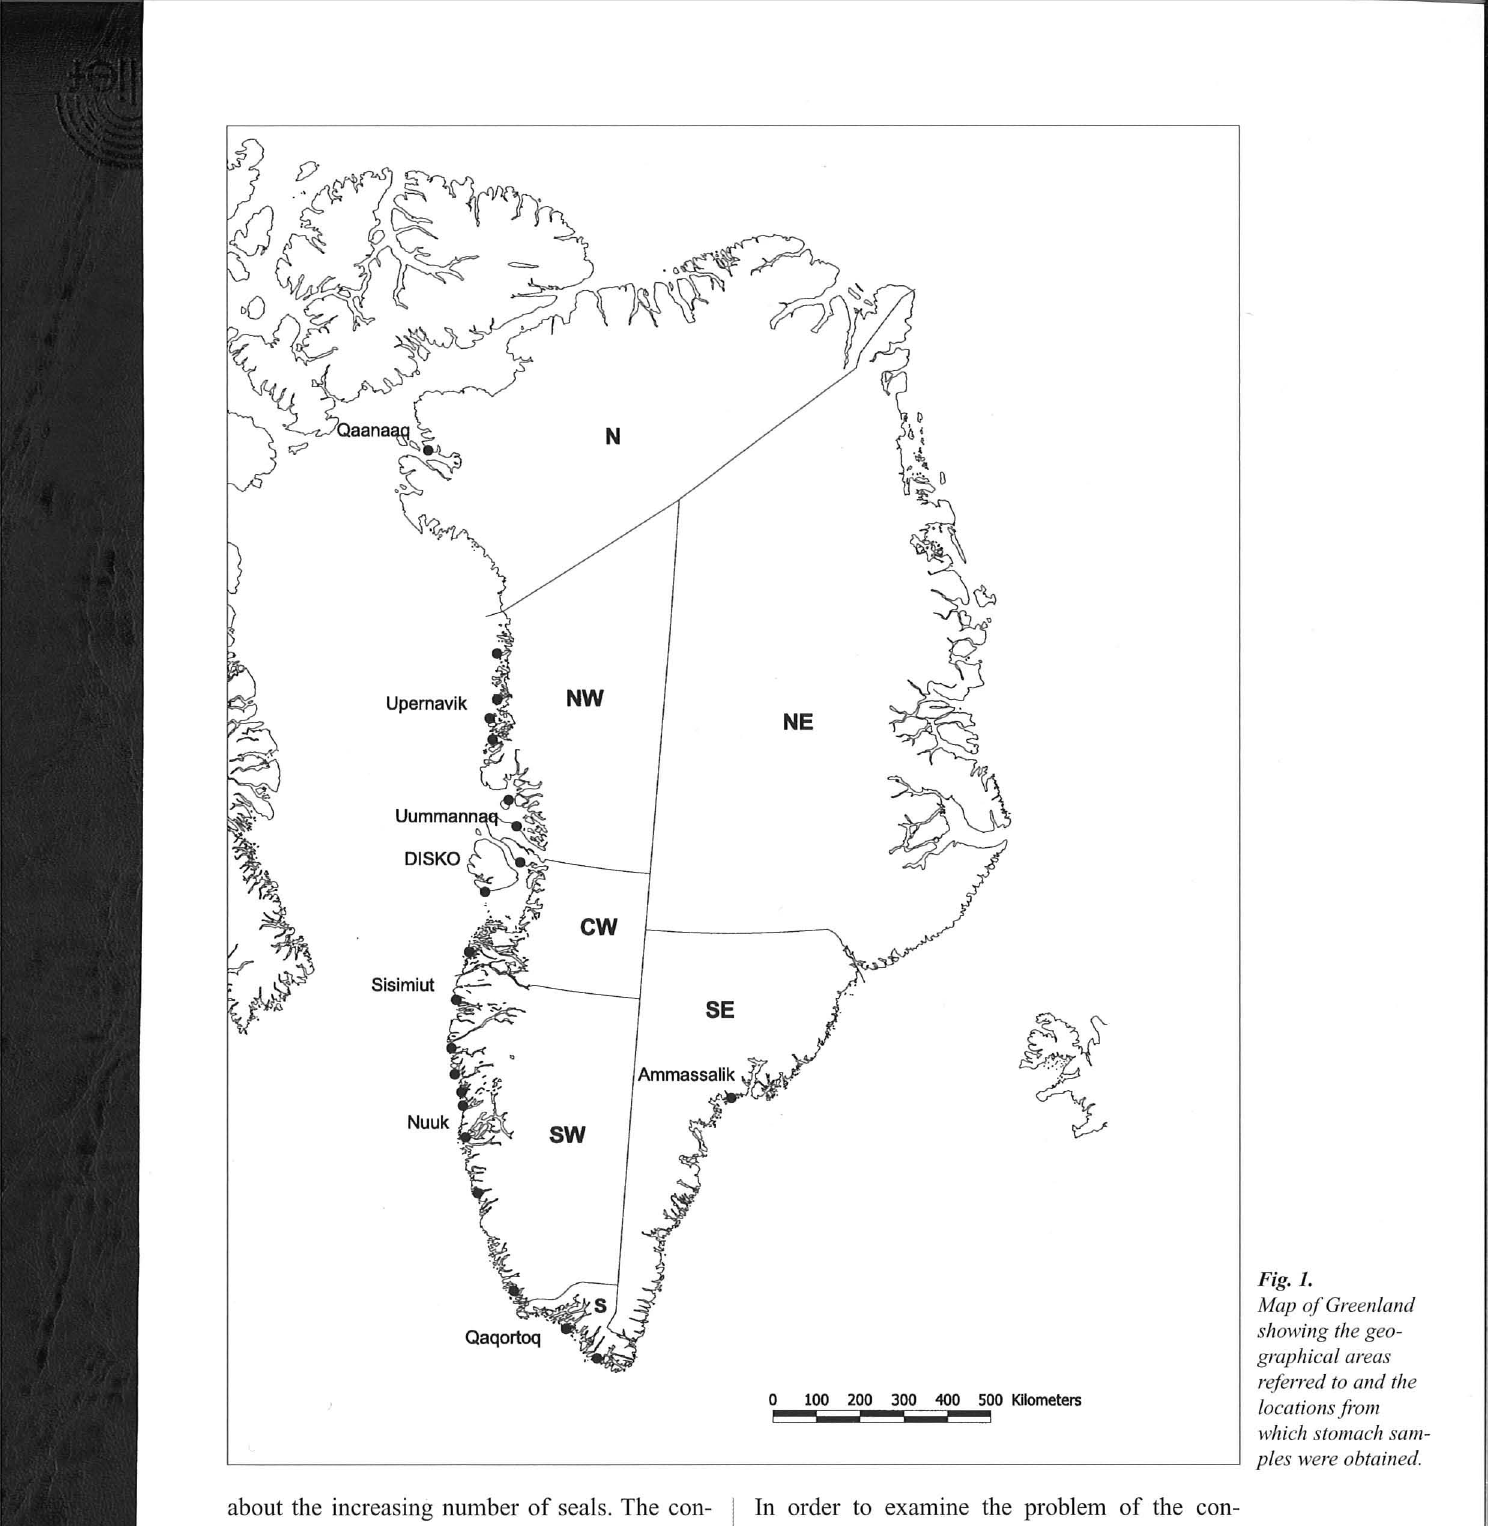
Fig. 1. Map of Greenland showing the geo graphical areas referred to and the locations jimll which stomach sam ples were